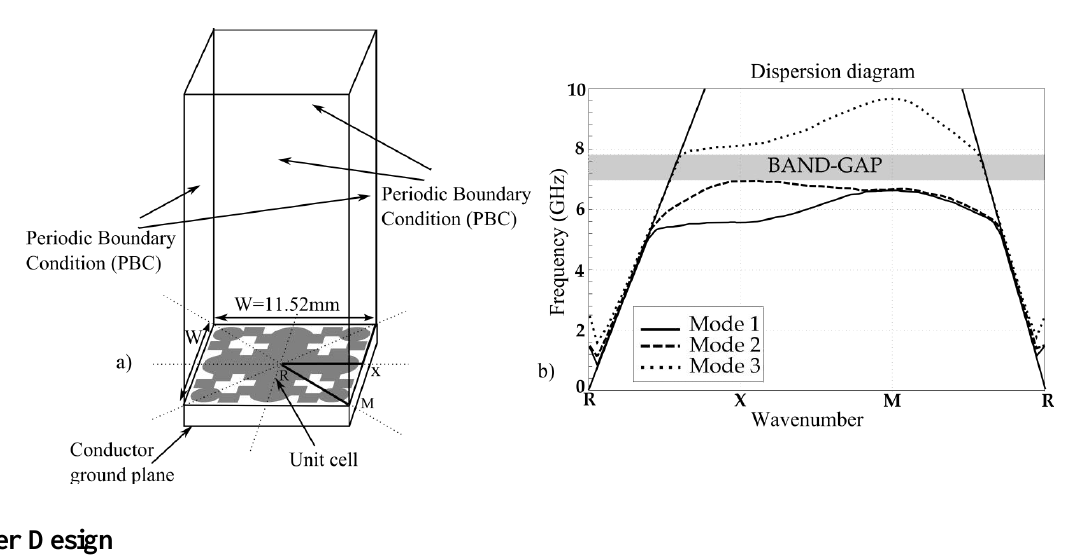
Figure 1. ( a ) Unit-cell resonator. The applied boundary conditions with the irreducible Brillouin triangle; and ( b ) Dispersion diagram of the periodic